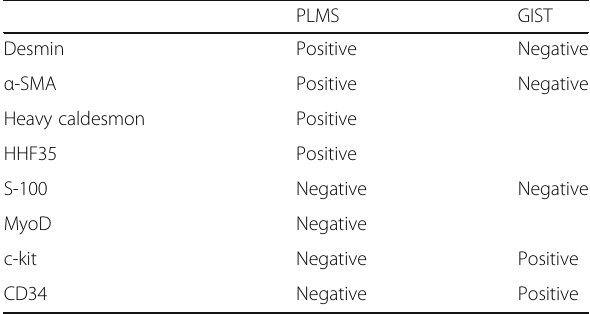
Table 1 Immunohistochemical findings about PLMS and gastric GIST specimen resected 2 years previously. Heavy caldesmon, HHF35, and MyoD staining about GIST had not been performed